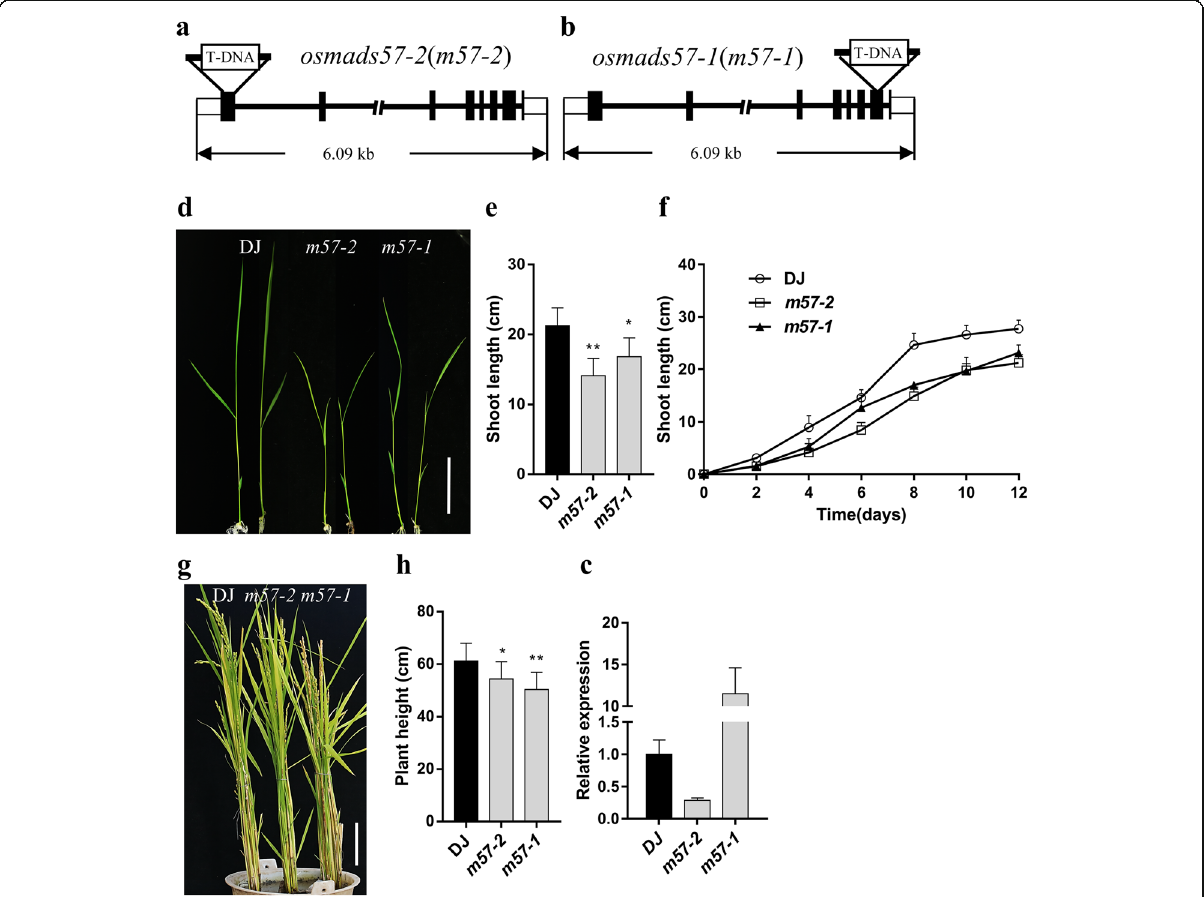
Fig. 1 Phenotypes of the m57 – 2 and m57 – 1 mutants. a and b Schematic diagram indicating the T – DNA insertion site in genomic region in m57 – 2 ( a ) and m57 – 1 ( b ). c Transcript levels of OsMADS57 in mutants and wild type lines by Q – PCR analysis. d The 10-day-old wild type and osmads57 plants grown in standard 1/2 MS medium. Bars = 5 cm. e Shoot length of 10-day-old wild type and osmads57 seedlings. f Shoot length of wild type and osmads57 plants grown in standard 1/2 MS medium for different days. g Morphology of wild type and osmads57 plants at maturity. Bars = 10 cm. h Plant height of wild type and osmads57 plants at maturity. DJ, wild type; m57 – 2 , osmads57 – 2 ; m57 – 1 , osmads57 – 1 . Three independent experiments were conducted with similar results. The data are means± SD ( n = 30). Error bars indicate SD. The statistical significance of the measurements was determined by Student ’ s t -test. Asterisks indicate the significant difference between osmads57 and wild type ( t – test, * P < 0.05, ** P < 0.01 or *** P <